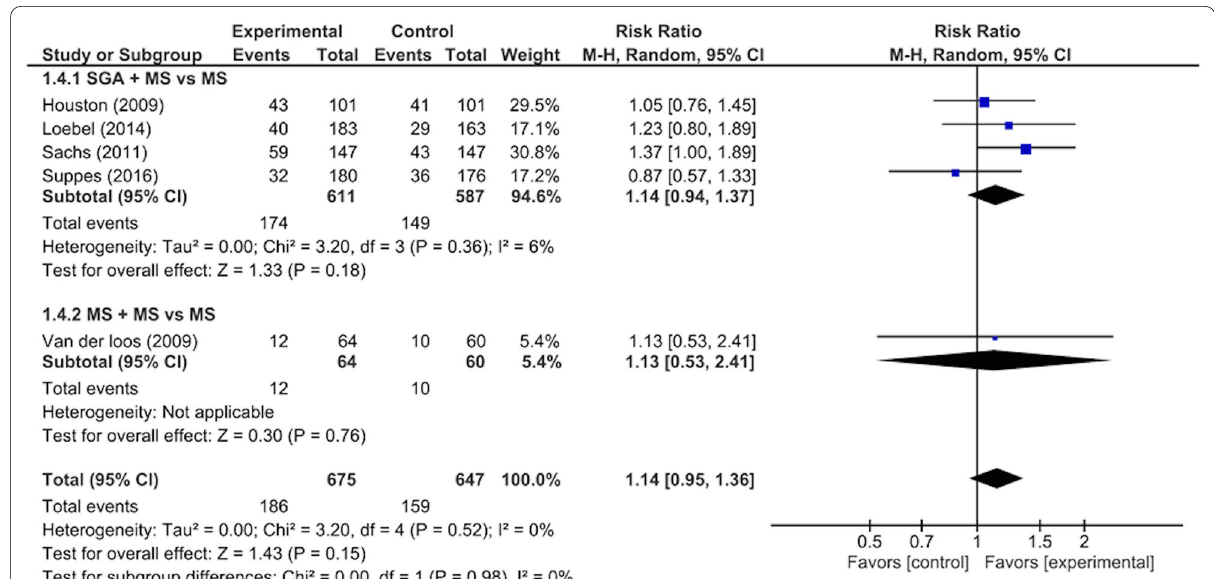
Fig. 8 Forest plot of post-intervention treatment effect sizes for dropout rate for all reasons during study period. Subgroup analysis of types of combination therapy. CI, confidence interval; SD, standard deviation; MS, mood stabilizers, including lamotrigine, lithium, and valproate; SGA, second-generation antipsychotics